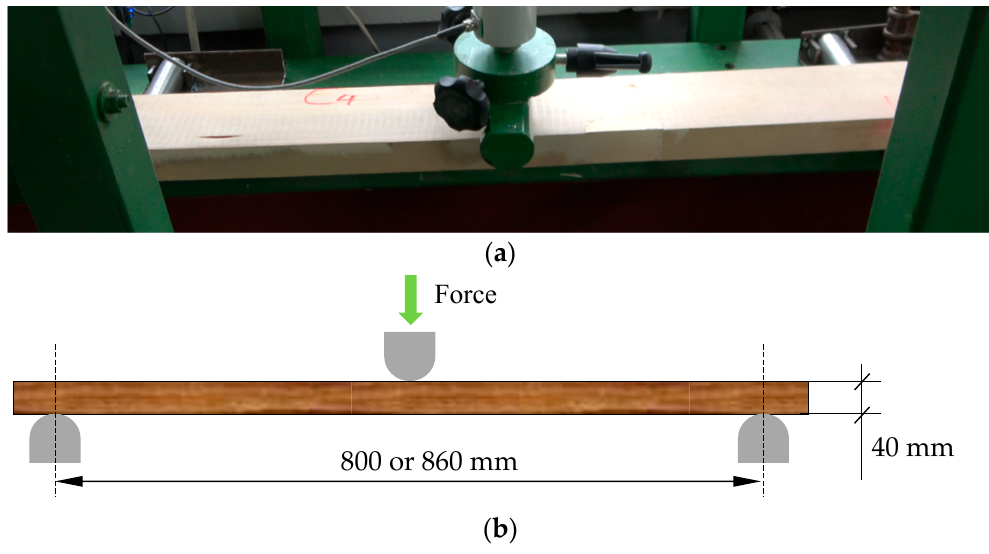
Figure 4. ( a ) Arrangement of the specimen in the testing machine, ( b ) loading diagram.